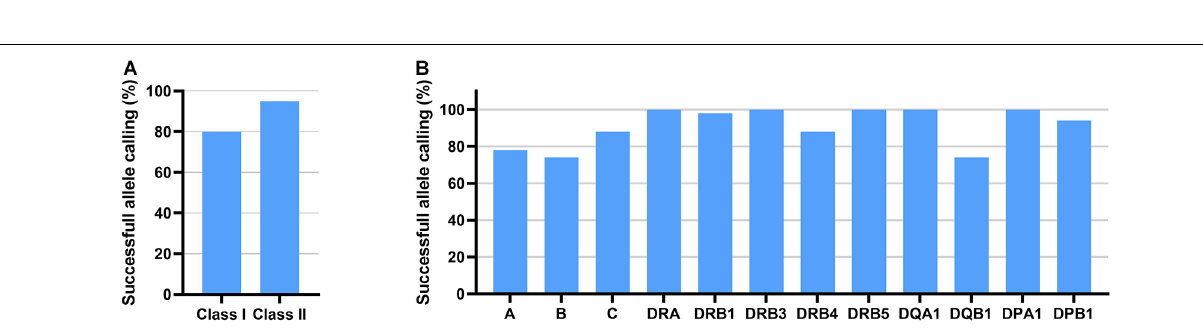
Frontiers in Genetics |